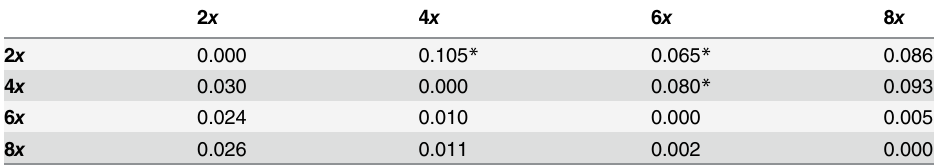
Table 4. Pair-wise ploidy matrix. Nei ’ s unbiased genetic distance (D) is shown below diagonal and values for genetic differentiation ( Φ PT ) are shown above diagonal. * P <